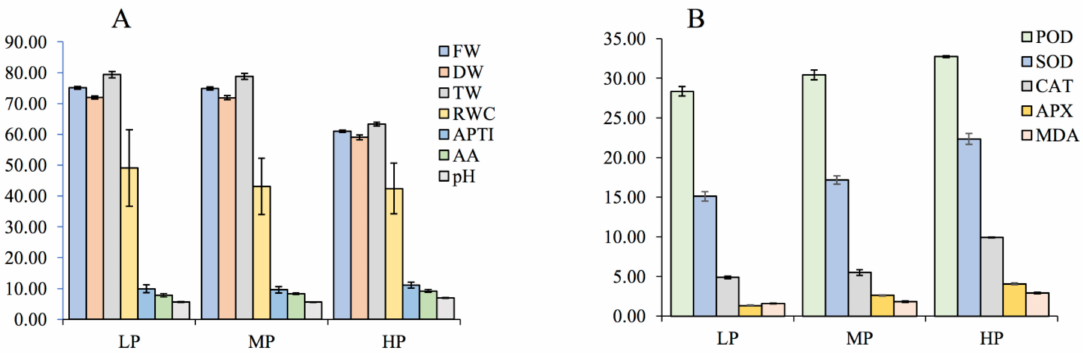
Figure 3. Site-specific variation in APTI of P. dulce ( A ) APTI and related parameters ( B ) Variation in the antioxidant enzymes activities of POD, SOD, CAT and APX (EU mg − 1 protein) at three di ff erent sites and MDA content ( µ g g − 1 fw). Data represents mean ± SD ( n =